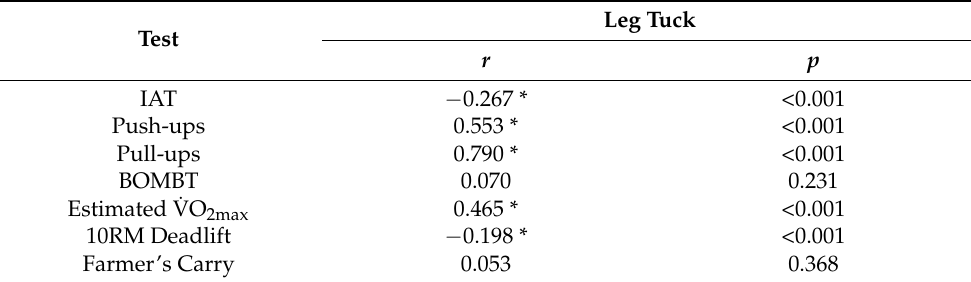
Table 2. Descriptive data (mean ± SD) for fitness test performance (Illinois agility test [IAT], metronome push-ups, pull-ups, 4.54 kg backwards overhead medicine ball throw [BOMBT], leg tuck, estimated maximal aerobic capacity [ ˙VO 2max ] from the 20 m multistage fitness test, 10RM deadlift, and the farmer’s carry) for firefighter trainees.